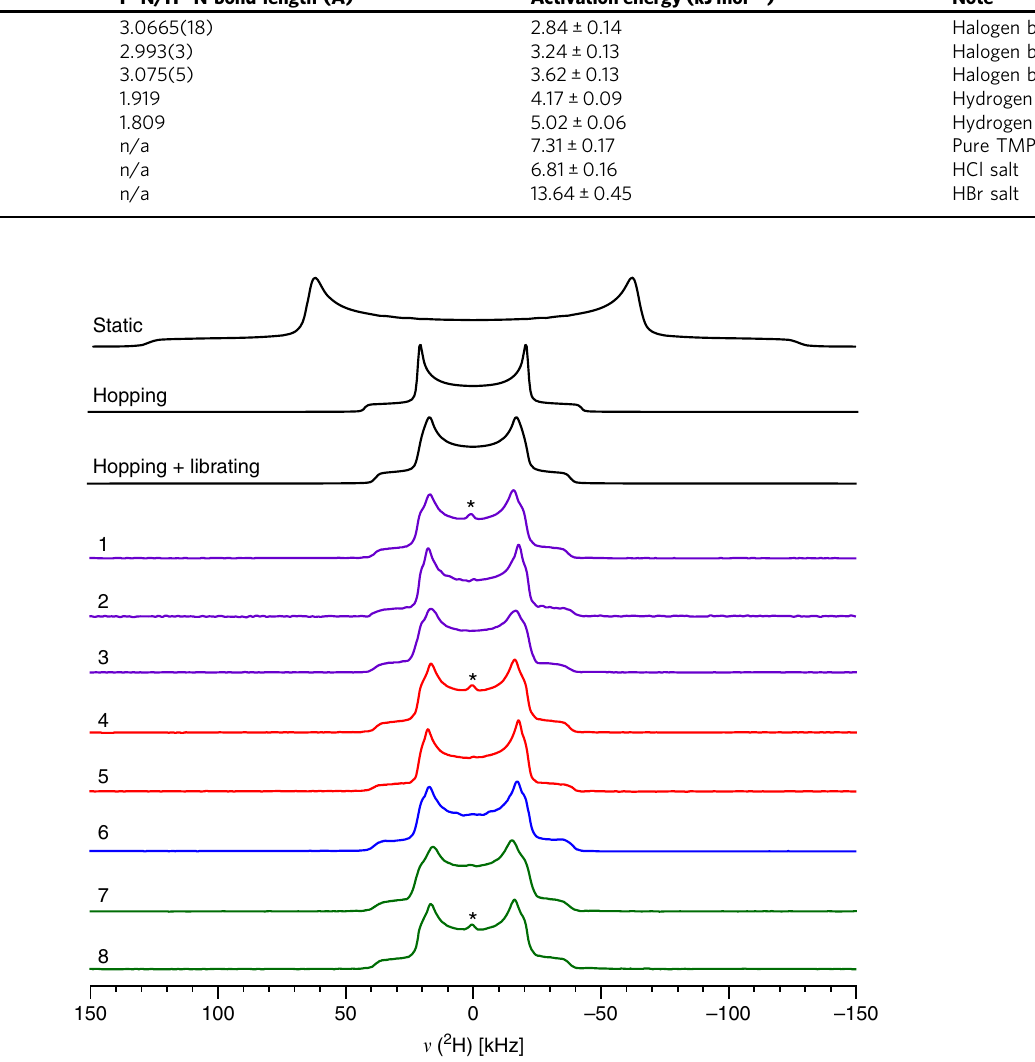
Table 1 Methyl group rotational activation energy for each compound derived from the T 1 relaxation experiments Compound